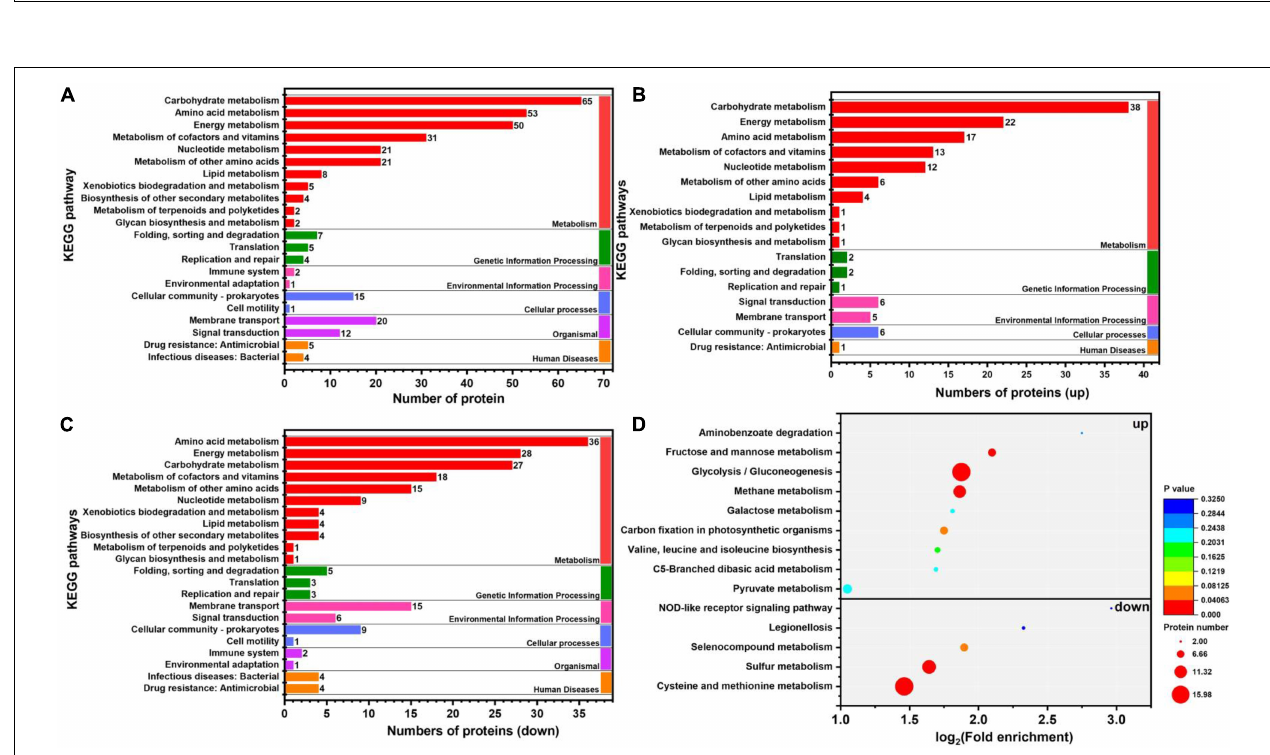
FIGURE 5 | Kyoto Encyclopedia of Genes and Genomes (KEGG) pathway and enrichment analysis of G40 and G120–20 (+betaine). (A) KEGG pathway classification of differential protein. (B) The enrichment analysis of the KEGG pathway (up proteins). (C) The enrichment analysis of the KEGG pathway (down proteins). (D) The enrichment analysis of the KEGG pathway (up and down proteins). [The p -value (corrected) <